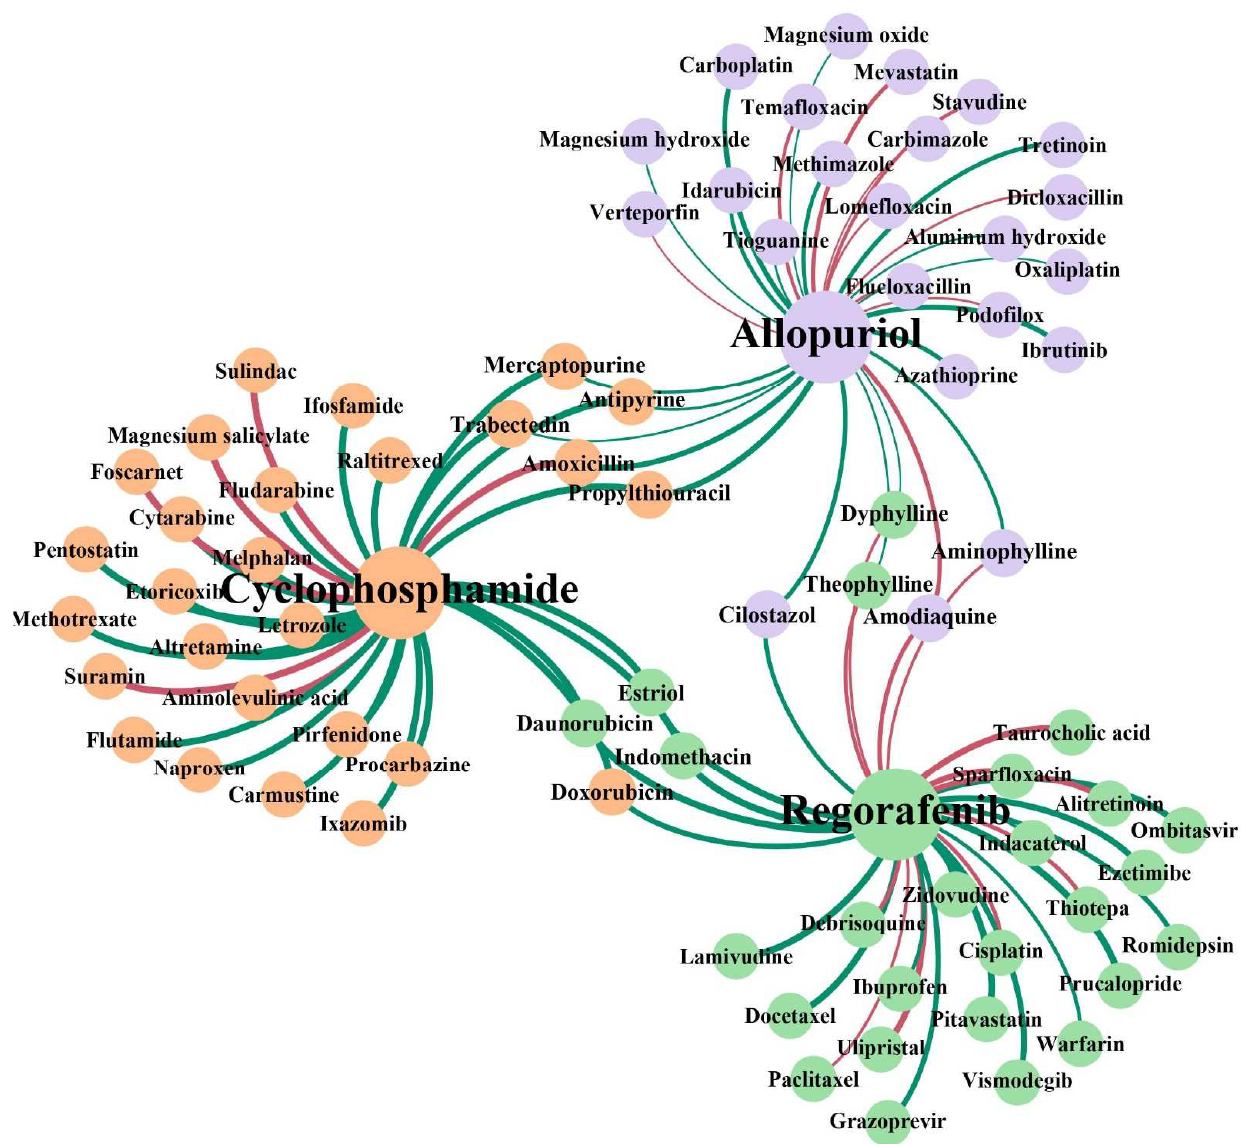
Figure 10. Network visualization of the newly discovered and known DDIs of the top 30 in each case study. The three colors of the node represent the three case studies. The red lines represent the interactions with no support and the green lines represent confirmed interactions. The thickness of the line between any two nodes represents the prediction score of the interaction.